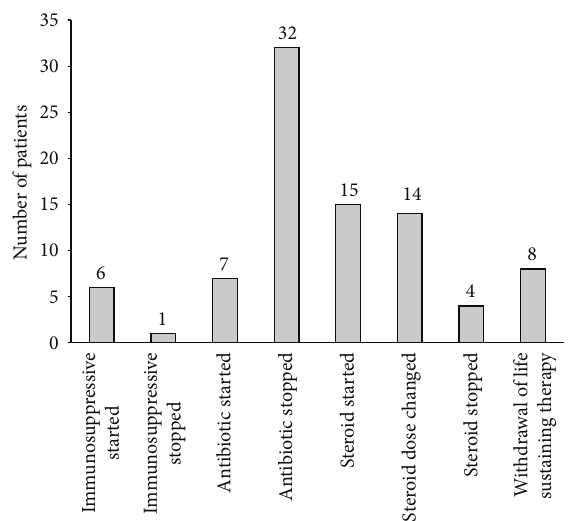
Figure 1: Change of therapy as a direct result of biopsy finding.